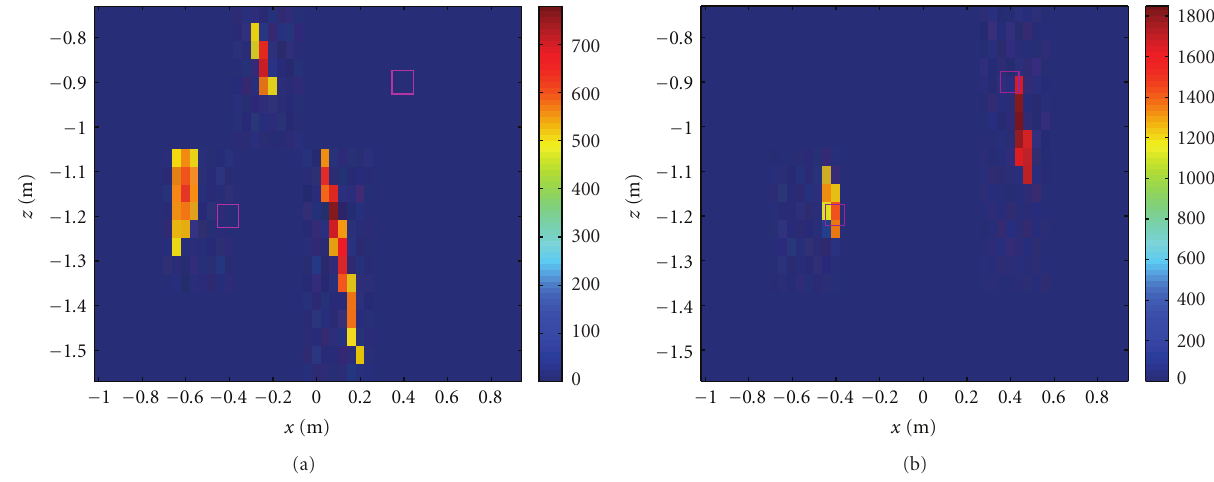
Figure 5: Image obtained with the through-wall radar scattered field data by TR-MUSIC algorithm; colors represent the pseudospectrum value: (a) on the scattered data without migration procedure; (b) on the scattered data after migration procedure.